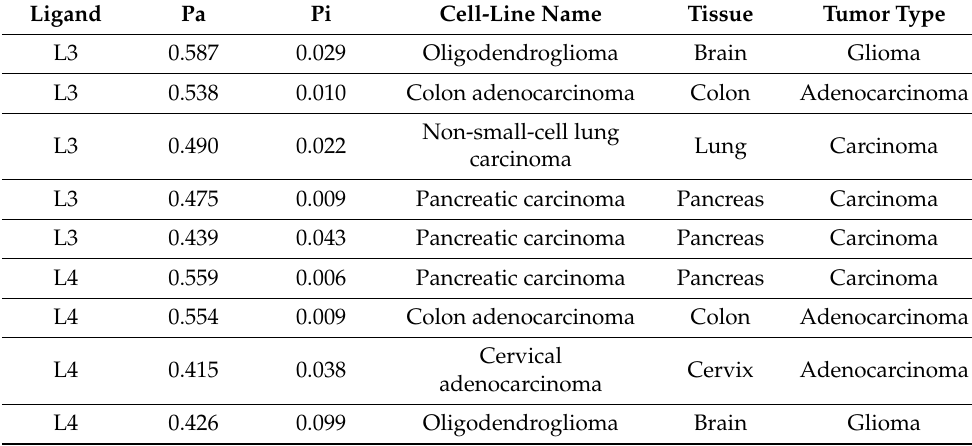
Table 8. Cancer cell line prediction results for the ligand—Pa (probability “to be active”), Pi (proba- bility “to be